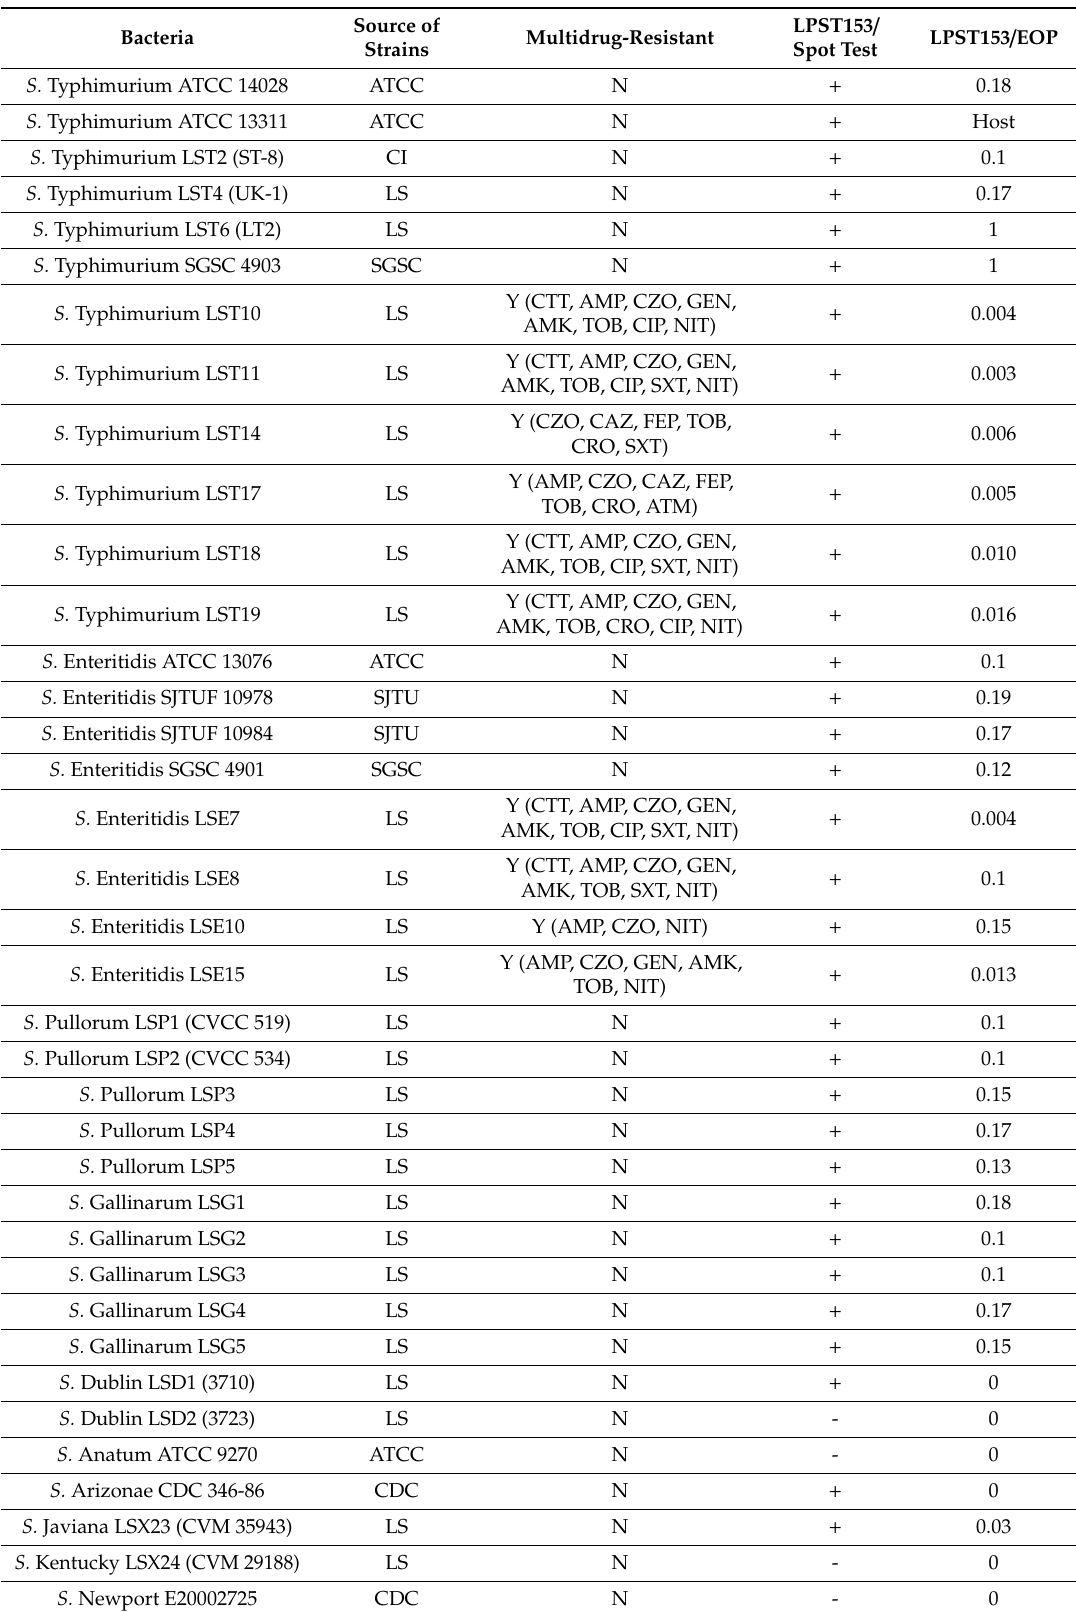
Table 1. Host range of phage